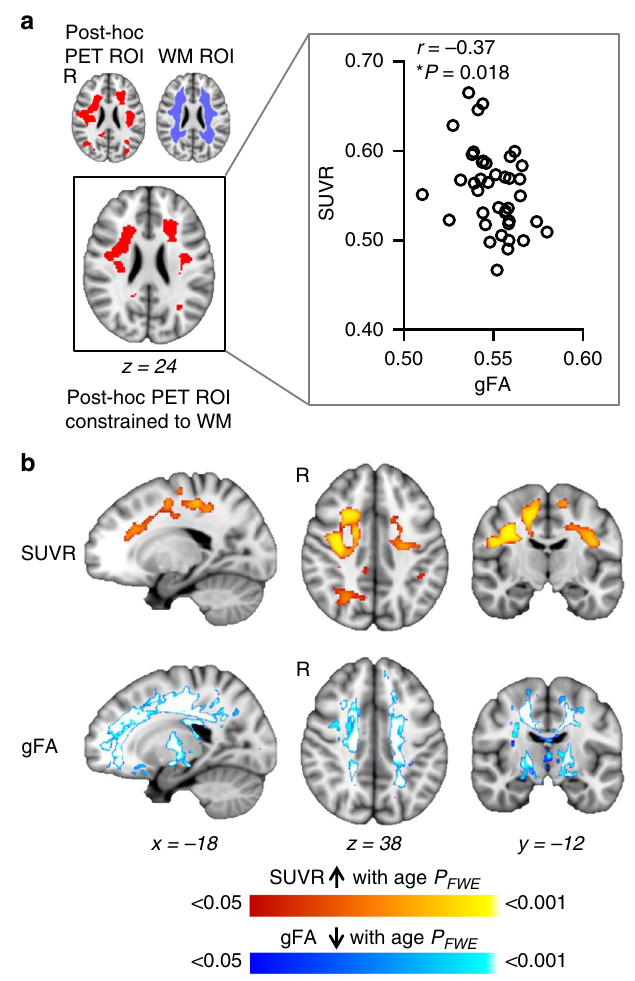
Fig. 2 [ 11 C]Martinostat uptake correlates and co-localizes with alterations in white matter microstructure. a ( Left ) A post-hoc PET ROI was created from a binary mask of the entire statistical map in Fig. 1 (red, depicting regions where SUVR increased with age), and was constrained to white matter. ROIs are overlaid onto the MNI 1 mm template in radiological orientation. ( Right ) Spearman correlation analysis between SUVR and gFA values extracted from the post-hoc PET ROI constrained to white matter ( n = 40). b Voxel-wise correlations of ( Top ) SUVR increases with age, controlled for sex, total grey matter volume/intracranial volume, white matter volume/intracranial volume, and cerebrospinal fl uid volume/ intracranial volume ( n = 41) and ( Bottom ) gFA decreases with age, controlled for sex ( n = 40). Statistical maps were overlaid onto the MNI 1 mm template in radiological orientation ( P FWE < 0.05; non-parametric permutation testing n = 10,000 permutations). Red – yellow represents regions where SUVR signi fi cantly increased with age and blue-light blue represents regions where gFA signi fi cantly decreased with